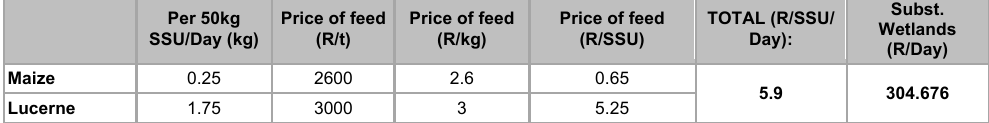
Estimated cost of feed, based on Department of Agriculture’s recommended dry feed diet () Subst. Per 50kg Price of feed Price of feed Price of feed TOTAL (R/SSU/ Wetlands SSU/Day (kg) (R/t) (R/kg) (R/SSU) Day): (R/Day) Maize